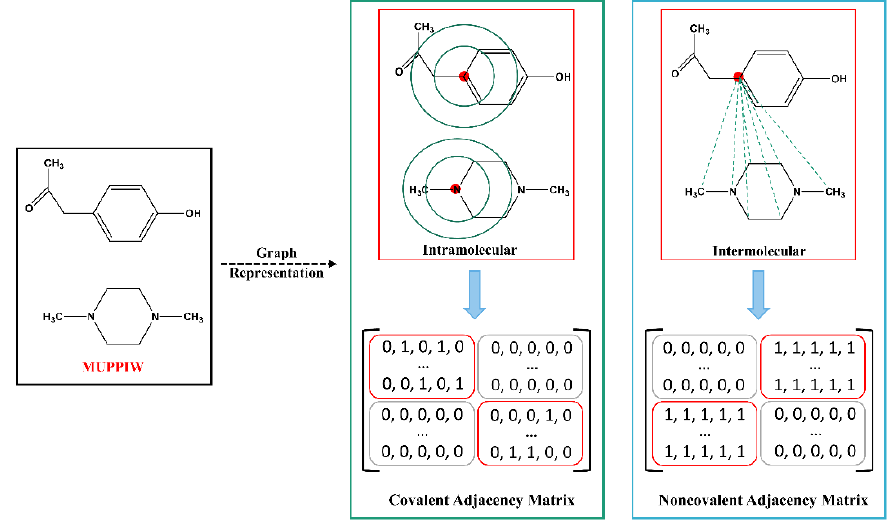
Figure 2. Schematic representation of covalent ( 𝐴 C ) and noncovalent ( 𝐴 NC ) adjacency matrix .